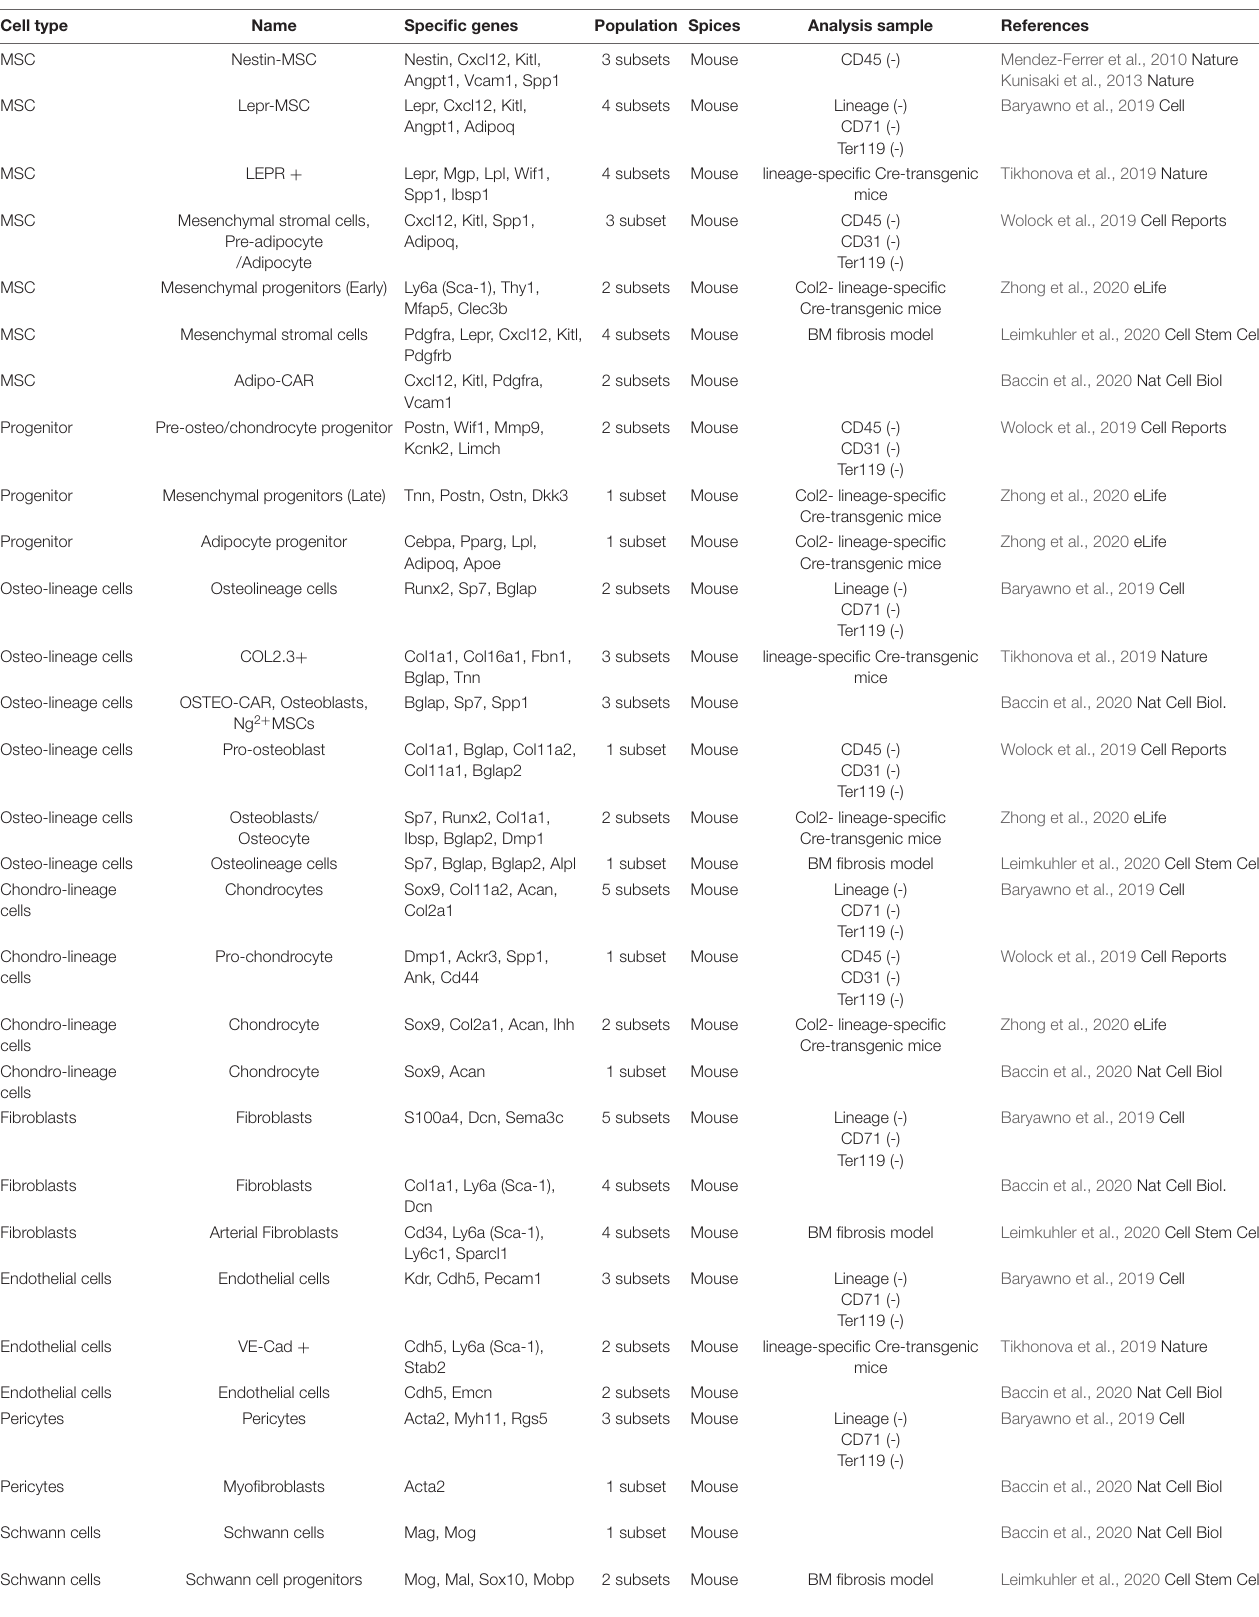
TABLE 1 | Classification of mouse BM cell